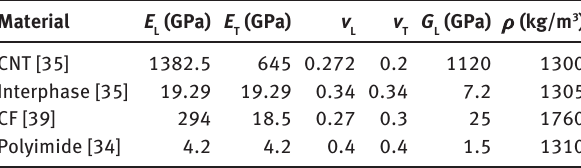
Table 1: Material properties of CNT, interphase, CF, and polyimide.